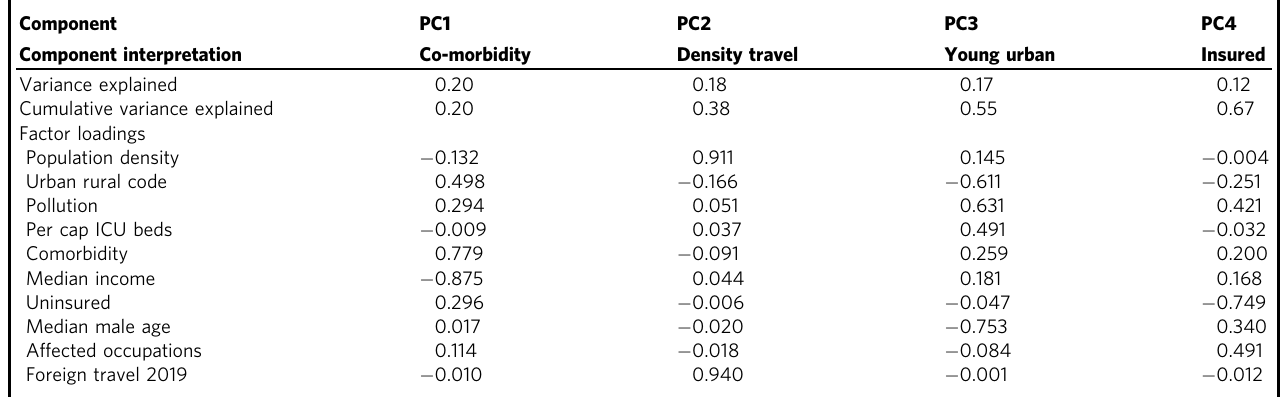
Table 2 Principal components analysis of COVID-19 death model independent